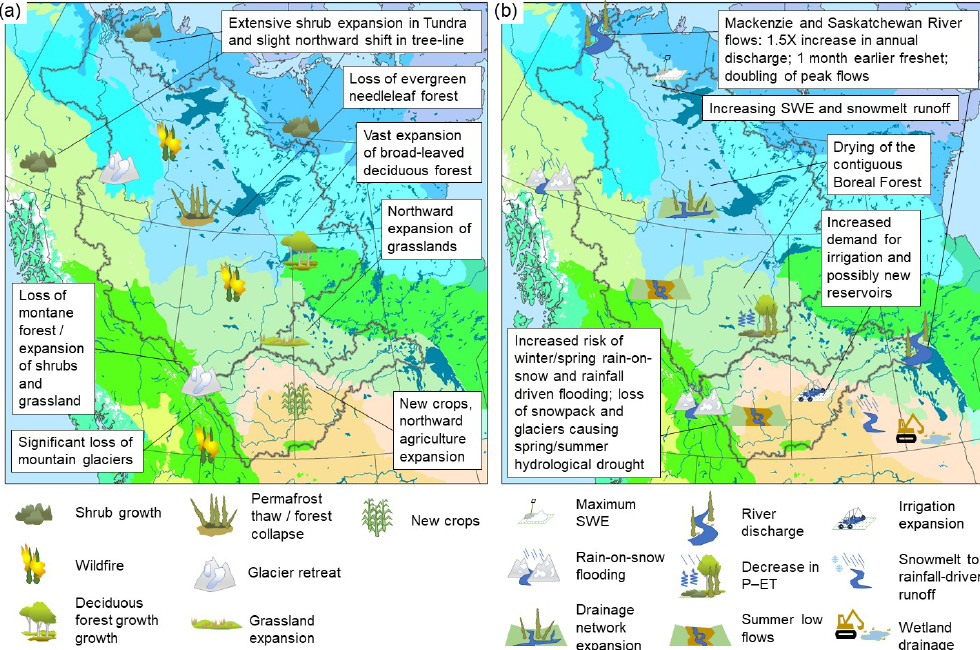
Figure 9. Conceptual depiction and synthesis of surface changes over the CCRN region, by the late 21st century, for (a) land cover and vegetation and (b) hydrological regime and water management. The base map depicts the Level II Ecological Regions of North America as shown in Fig.